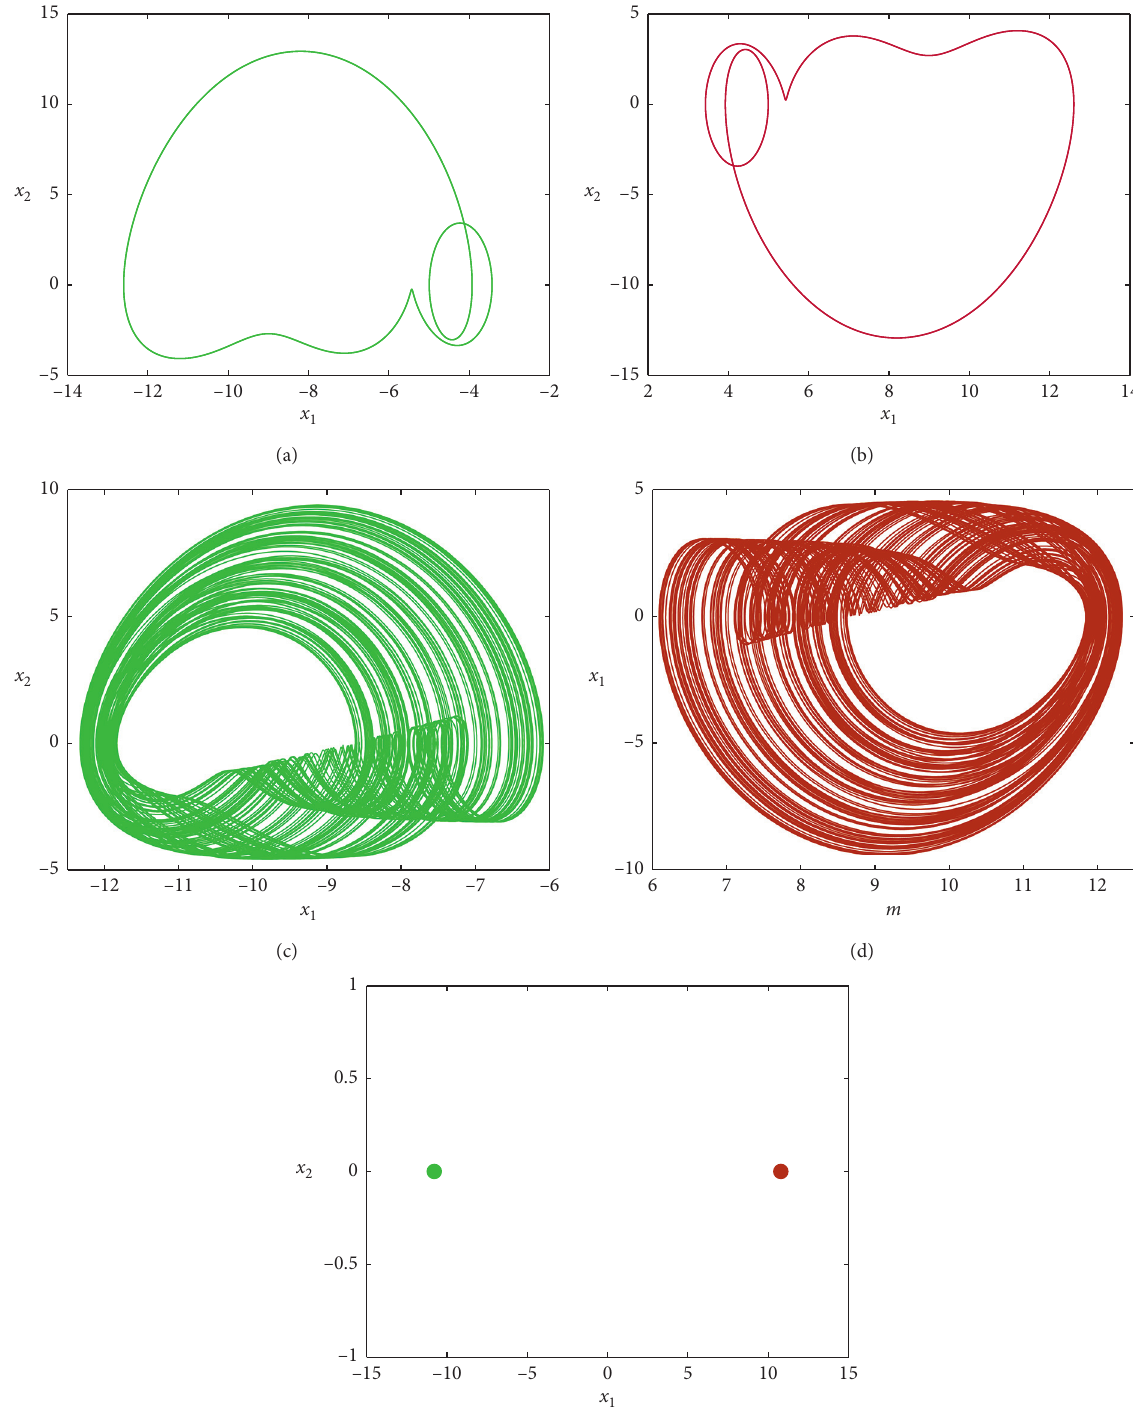
Figure 13: Coexistence of six different attractors (a pair of period-2 limit cycle, a pair of chaotic attractors, and a pair of fixed point attractor) for the following values of system parameters: a � 1 . 8, b � 3 . 8, c � 2 . 442, d � 1 . 35, e � 14 . 85, and m � 2 . 802. Initial conditions ( x ( 0 ) , x ( 0 ) , x ( 0 ) , x ( 0 )) are, respectively, ( ± 5 . 5 , 0 , 0 , 0 ) , ( ± 12 . 8 , 0 , 0 , 0 ) , and ( ± 10 . 1 , 0 , 0 , 0 ) 1 2 3 4 the schematic diagram of Figure 1. The following values of electronic circuit components are used during the experimental process: R c � R m � R � 10 k Ω , R b � 1 . 67 k Ω ,